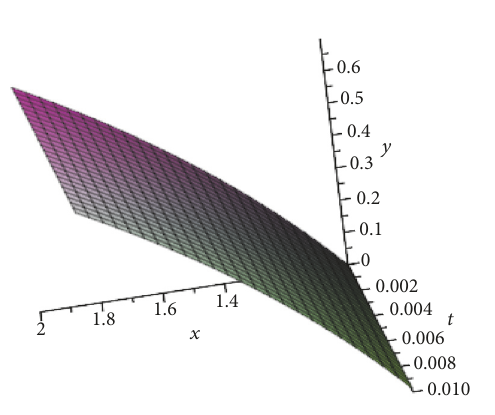
Figure 3: Numerical solution for (28) using VIMB when n=m=8 and 𝑡 = 0.01 .